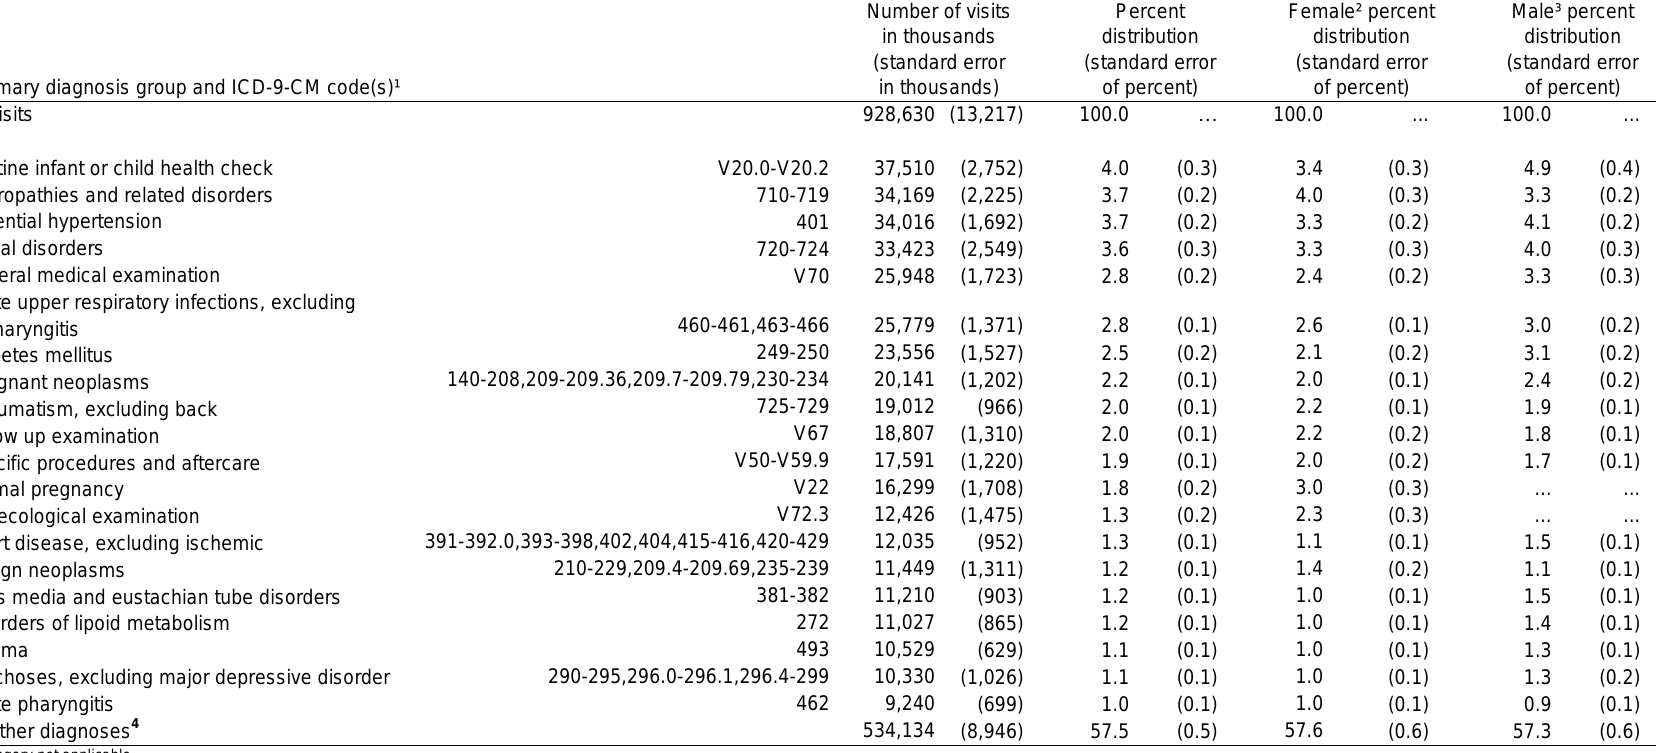
Table 16. Twenty leading primary diagnosis groups for office visits: United States,